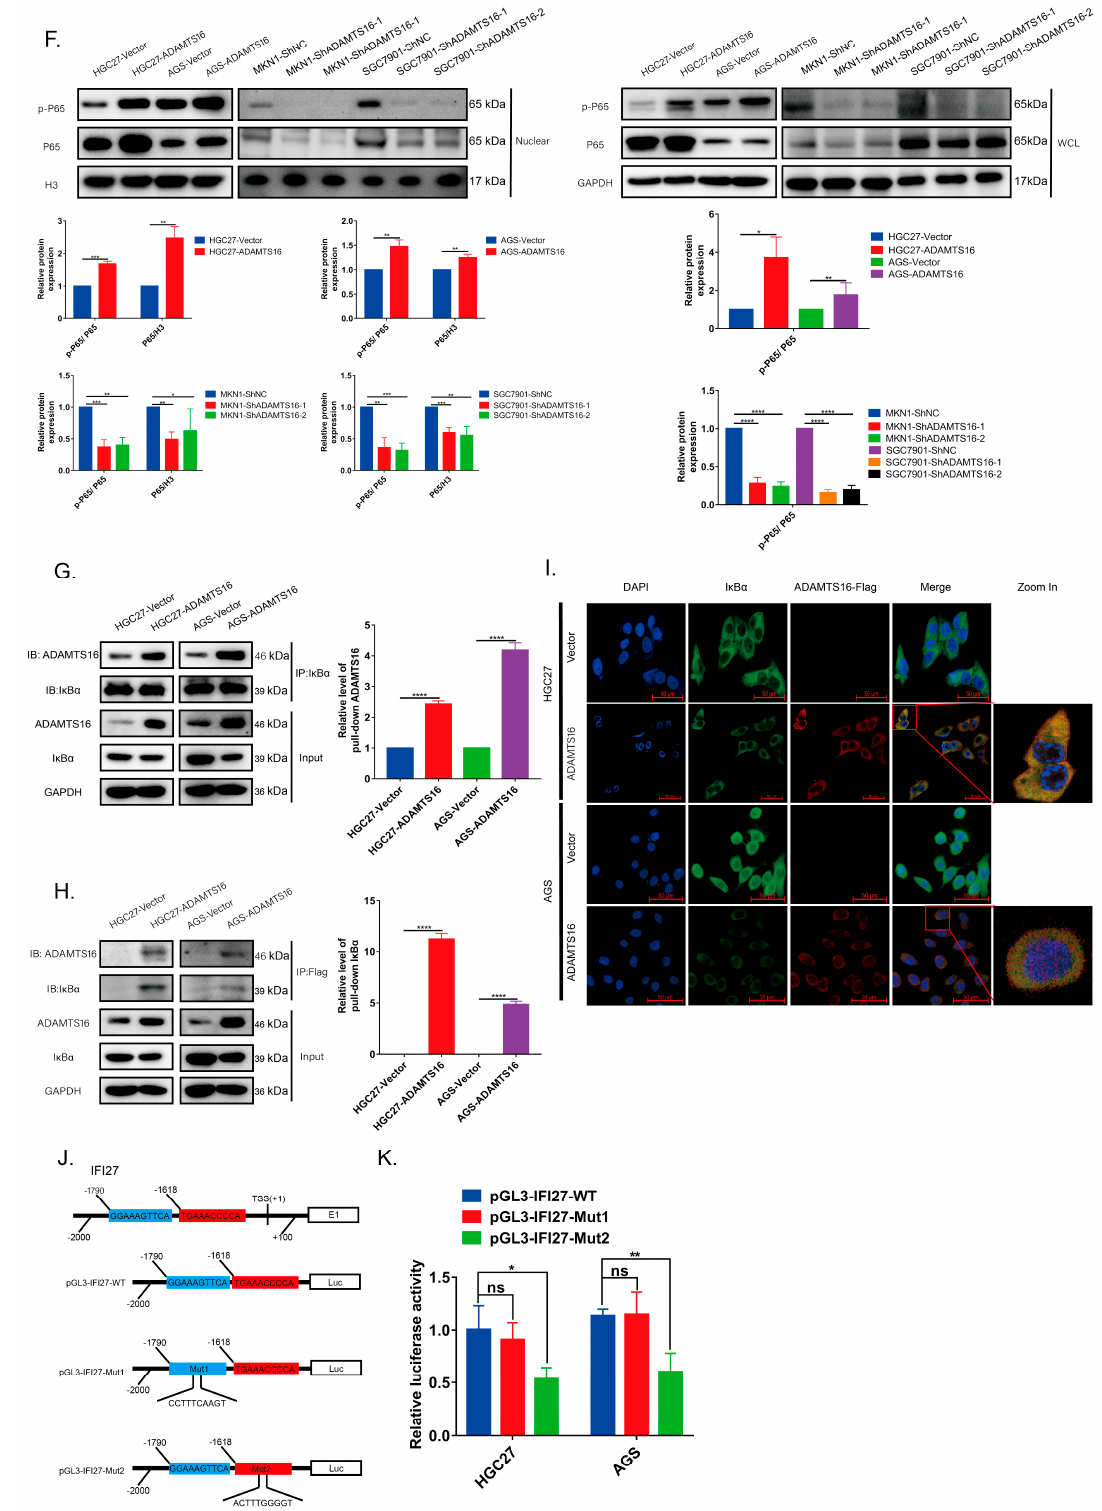
Figure 3. Ectopic ADAMTS16 expression promotes GC cell invasion and migration via the NF- κ B/IFI27 axis. ( A ) Heat map analysis showed altered genes in AGS-vector and AGS-ADAMTS16 cells. ( B ) Quantitative real-time polymerase chain reaction was performed to detect IFI27 mRNA